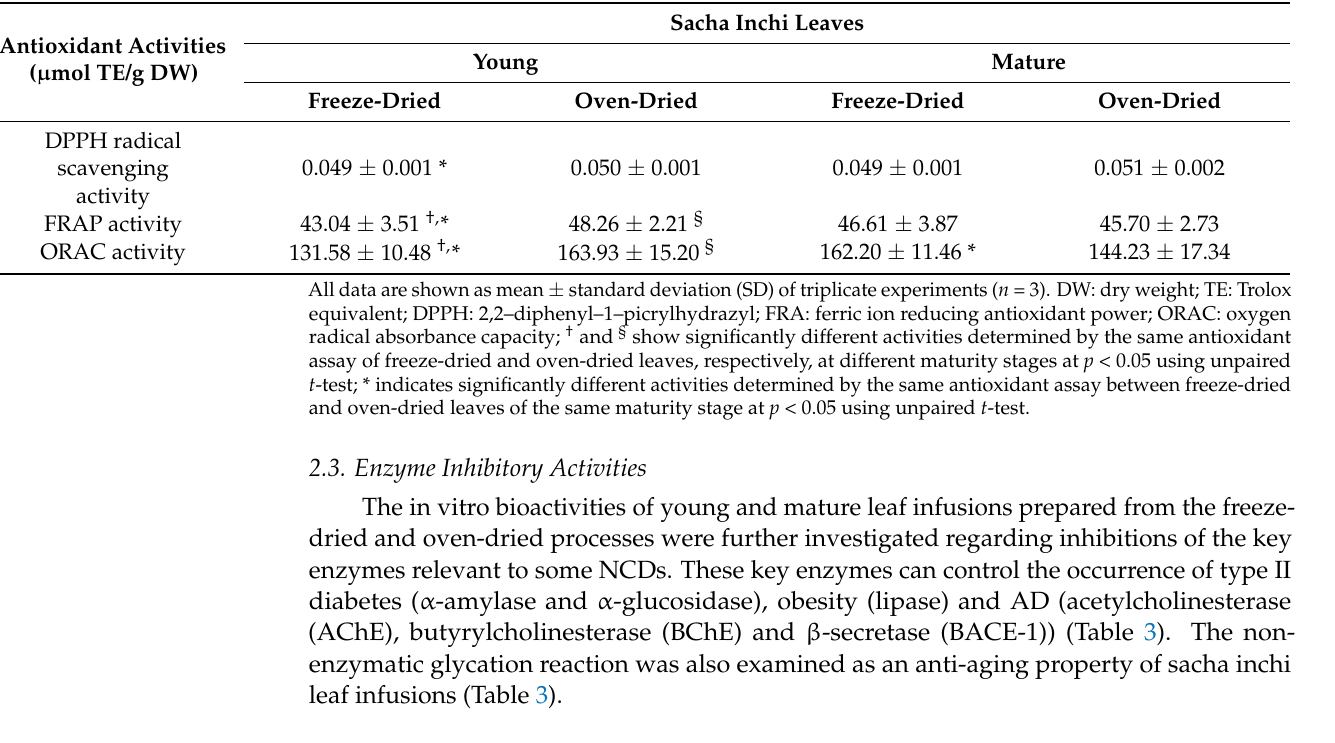
Table 3. Enzyme inhibitory activities and anti-glycation activities of aqueous extracts prepared from dried leaves of sacha